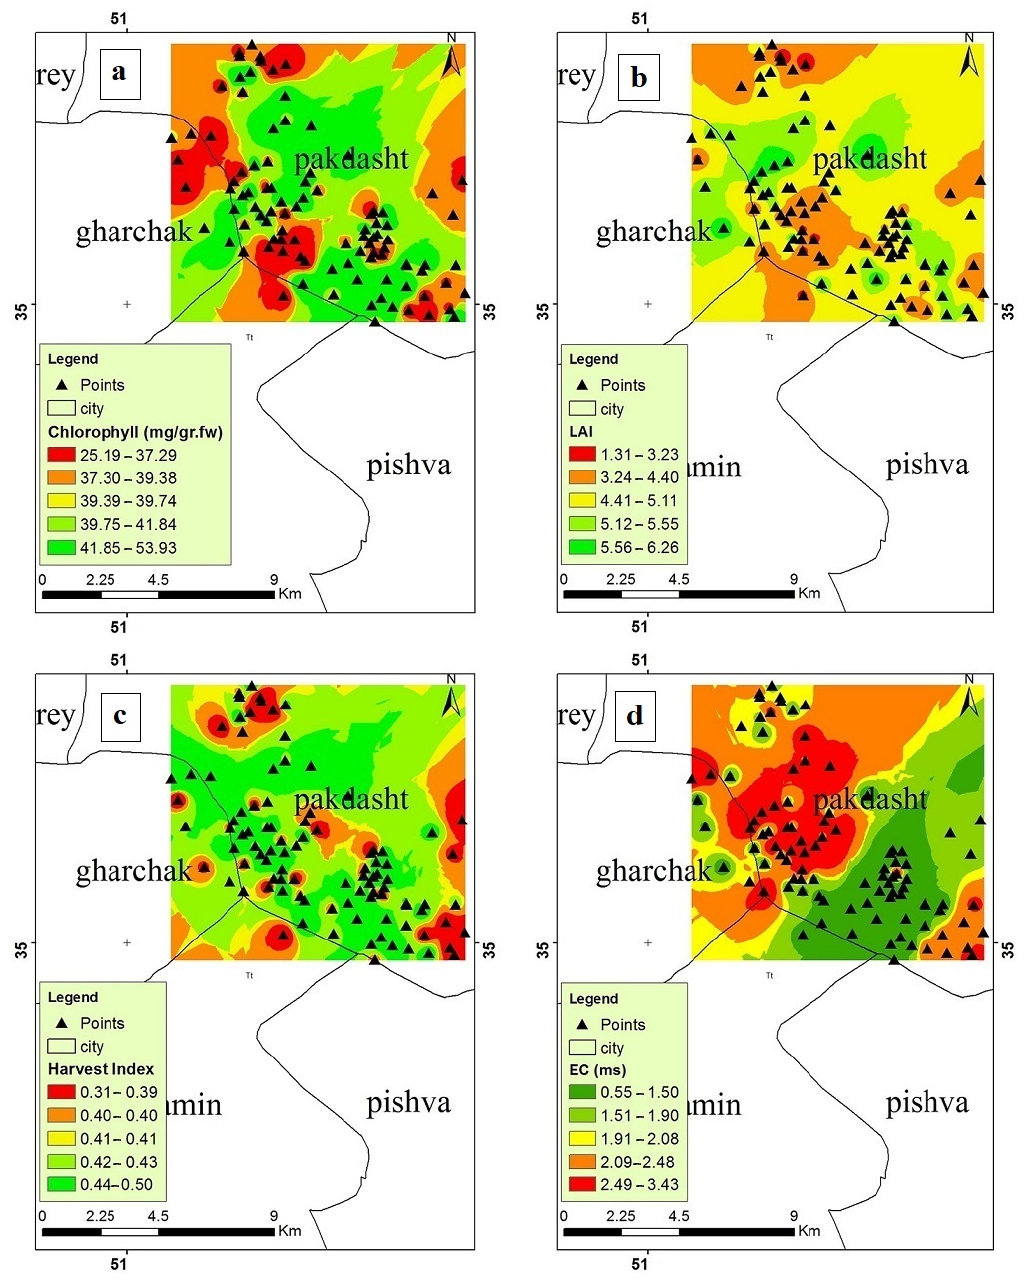
Figure 2. The range of plant and soil variables with a high impact on the wheat yield gap in the fields studied in Varamin Plain of Pakdasht, extracted from the results of the CPA approach. ( a ) The amount of leaf chlorophyll; ( b ) LAI; ( c ) Harvest Index; ( d ) Soil salinity.